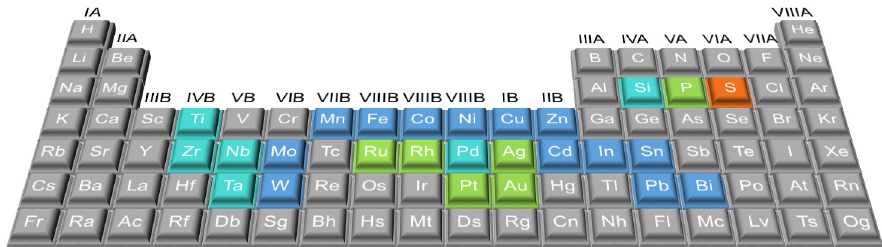
Figure 2. Chemical elements whose sulfide compounds have been widely used in photocatalytic hydrogen generation (blue boxes). Elements employed as dopants (green) and whose oxides or other compounds (cyan) were used to construct heterostructures with metal sulfides for hydrogen evolution are also marked. Please note that lanthanides and actinides are not shown.